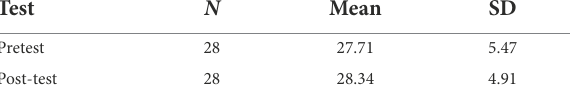
TABLE 3 Paired samples t-test for the control